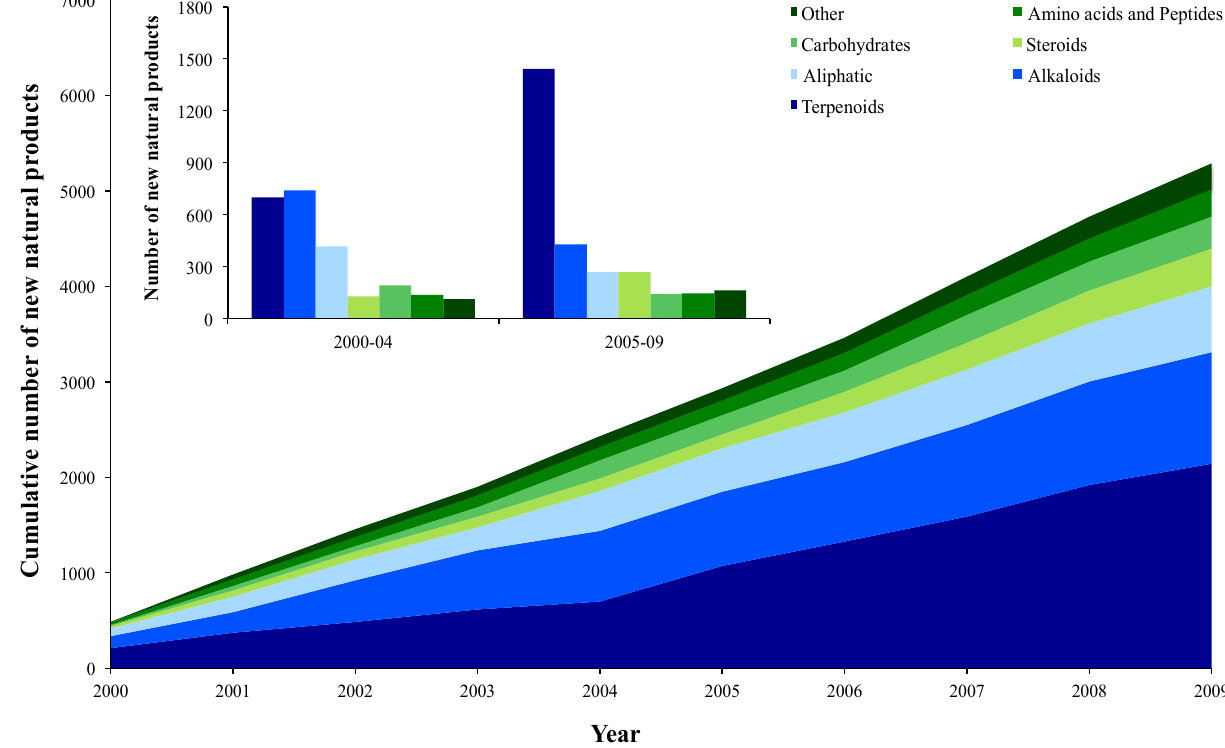
Figure 1. Chemical groups of new marine natural products from invertebrates. Cumulative number of new natural products from different chemical groups discovered from 2000 to 2009 (group “Other” include polyketides, simple aromatic, polypyrroles and oxygen heterocycles). Inset: Total number of new marine natural products from invertebrates discovered between 2000–2004 and 2005–2009 according to chemical